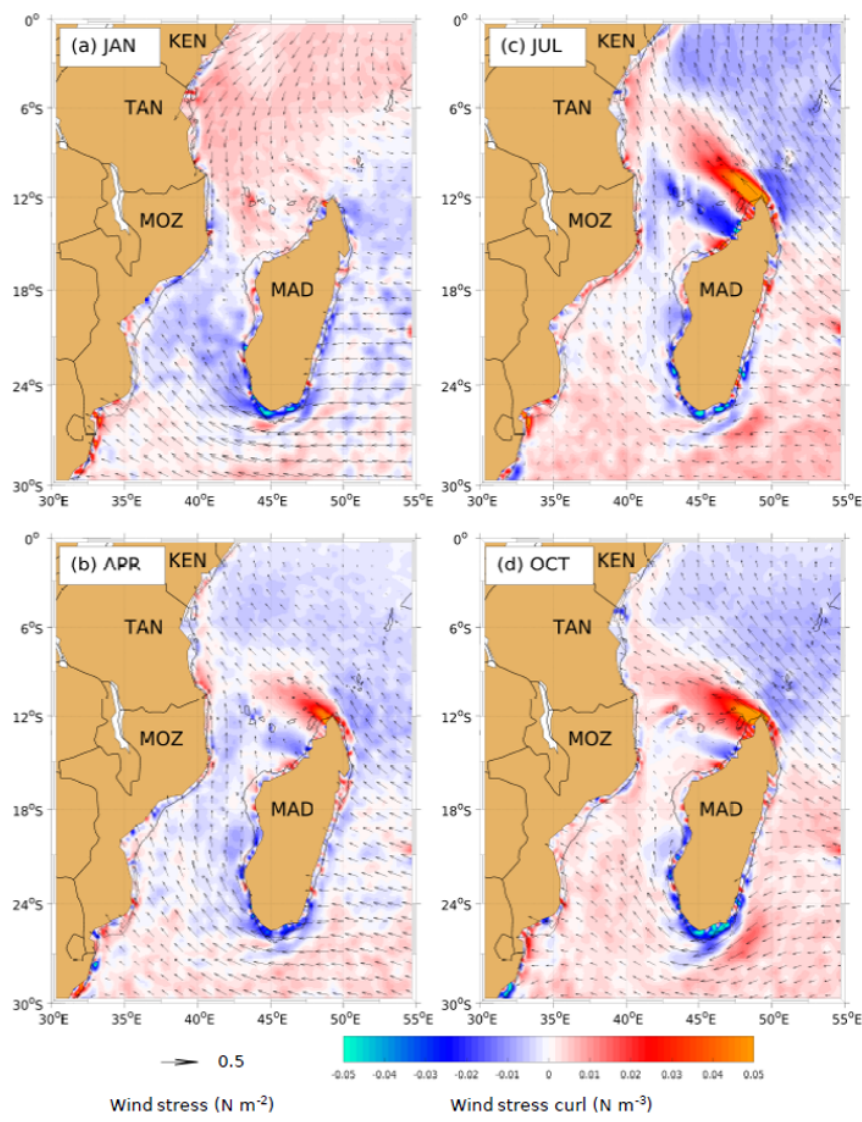
Figure 8. Climatological monthly means of wind stress (vectors) and wind stress curl (shading) during different seasons. Austral summer ( a , JAN), autumn ( b , APR), winter ( c , JUL) and spring ( d , OCT). Negative (blue) and positive (red) wind stress curl depicts favourable upwelling and downwelling areas, respectively. The data were extracted from the Scatterometer Climatology of Ocean Winds (SCOW), described by Risien and Chelton (2008); mapped globally with a spatial grid resolution of 1 / 4 ◦ × 1 / 4 ◦ ; estimated from a 10-year period, ranging between September 1999 and August 2009; and measured by